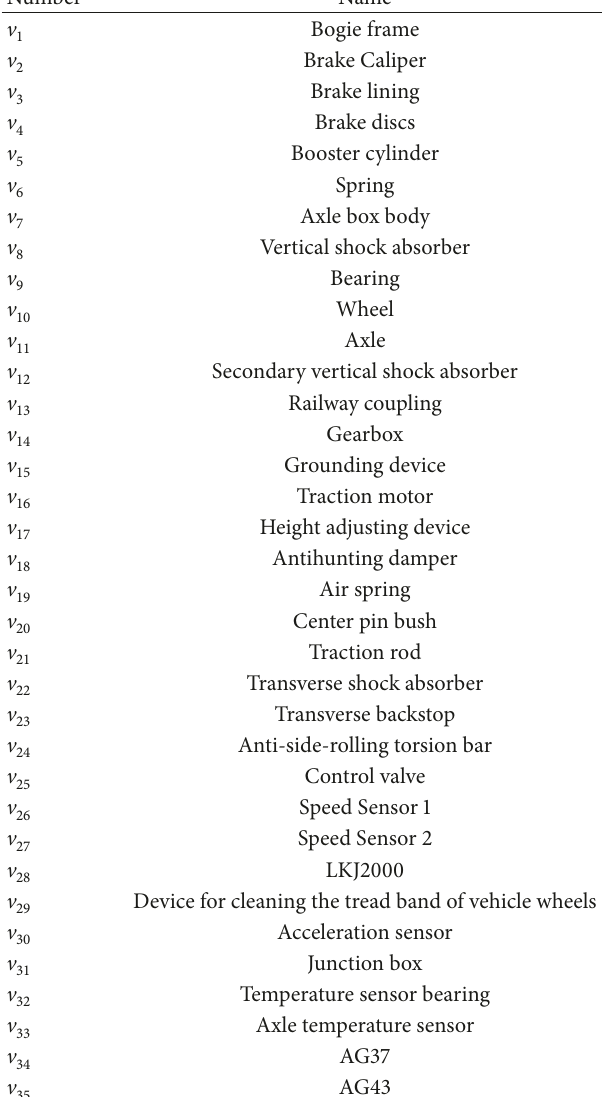
Table 1: Components in bogie